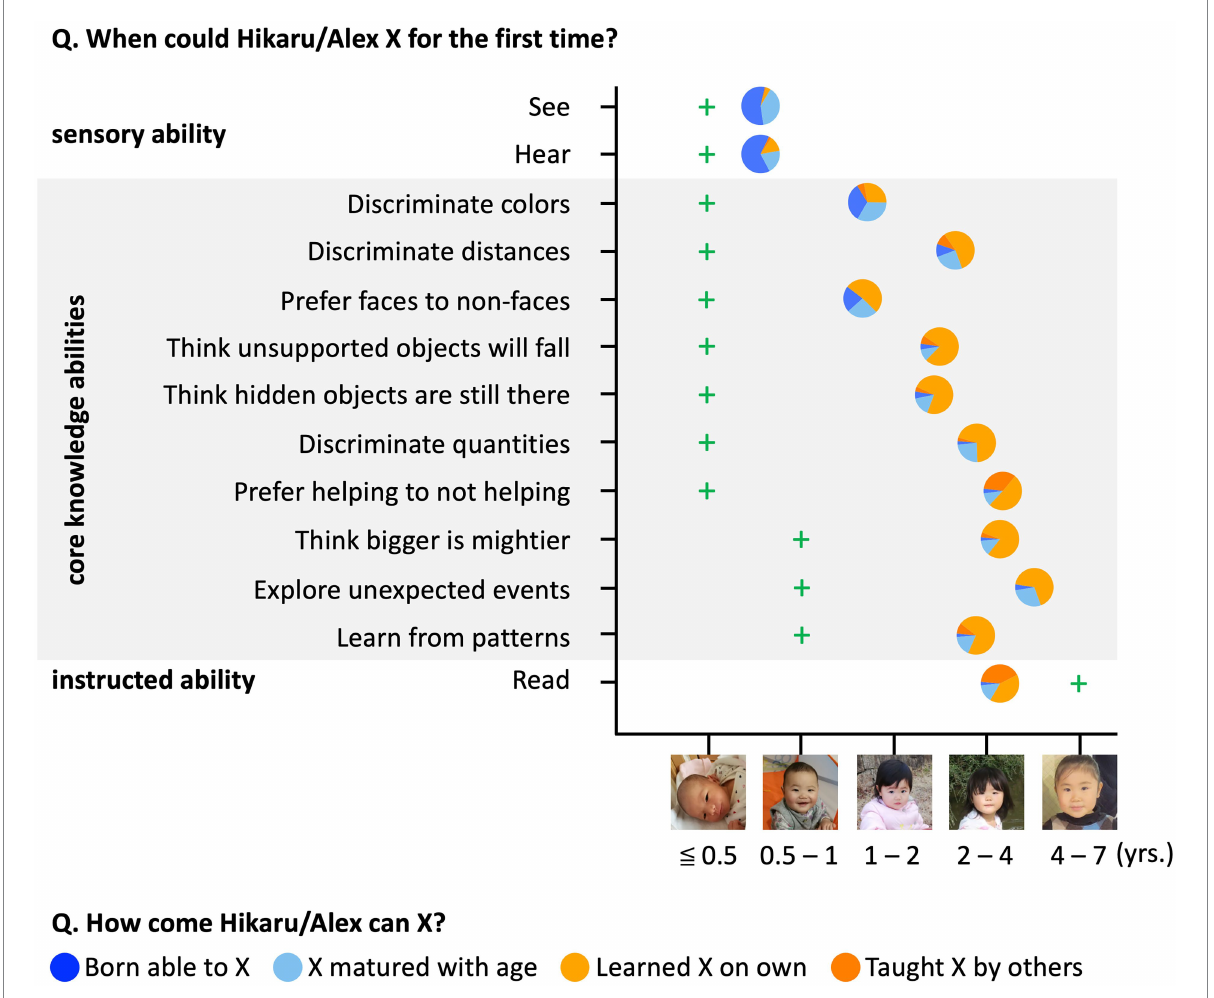
FIGURE 4 Methods and results for Study 2. Circles’ left–right positions represent participants’ age estimates. Circles’ colors represent the distribution of free responses. Green crosses indicate the earliest age category at which abilities have been documented in published